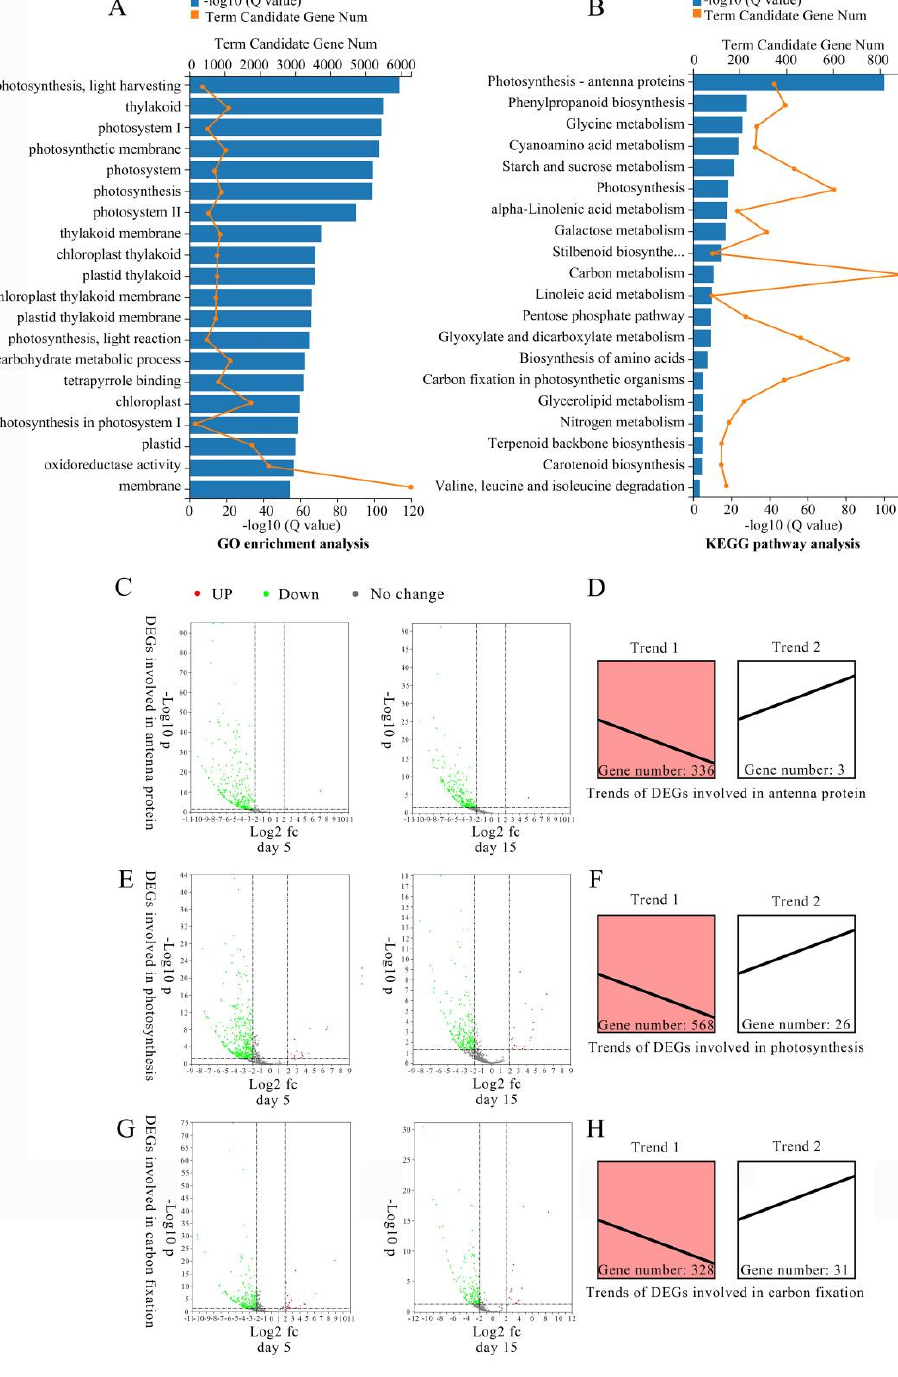
Figure 2. Analysis of DEGs involved in photosynthesis related pathways in M. sinostellata . ( A ) GO enrichment analysis of 22,433 DEGs. ( B ) KEGG enrichment analysis of 22,433 DEGs. The top 20 GO and KEGG Terms with the smallest Qvalue were selected to plot the chart, respectively. ( C ) Volcano plots of DEGs involved in antenna protein. ( D ) Trends of DEGs related to antenna protein. ( E ) Volcano plots of DEGs involved in photosynthesis. ( F ) Trends of DEGs related to photosynthesis. ( G ) Volcano plots of DEGs involved in carbon fixation. ( H ) Trends of DEGs related to carbon fixation.